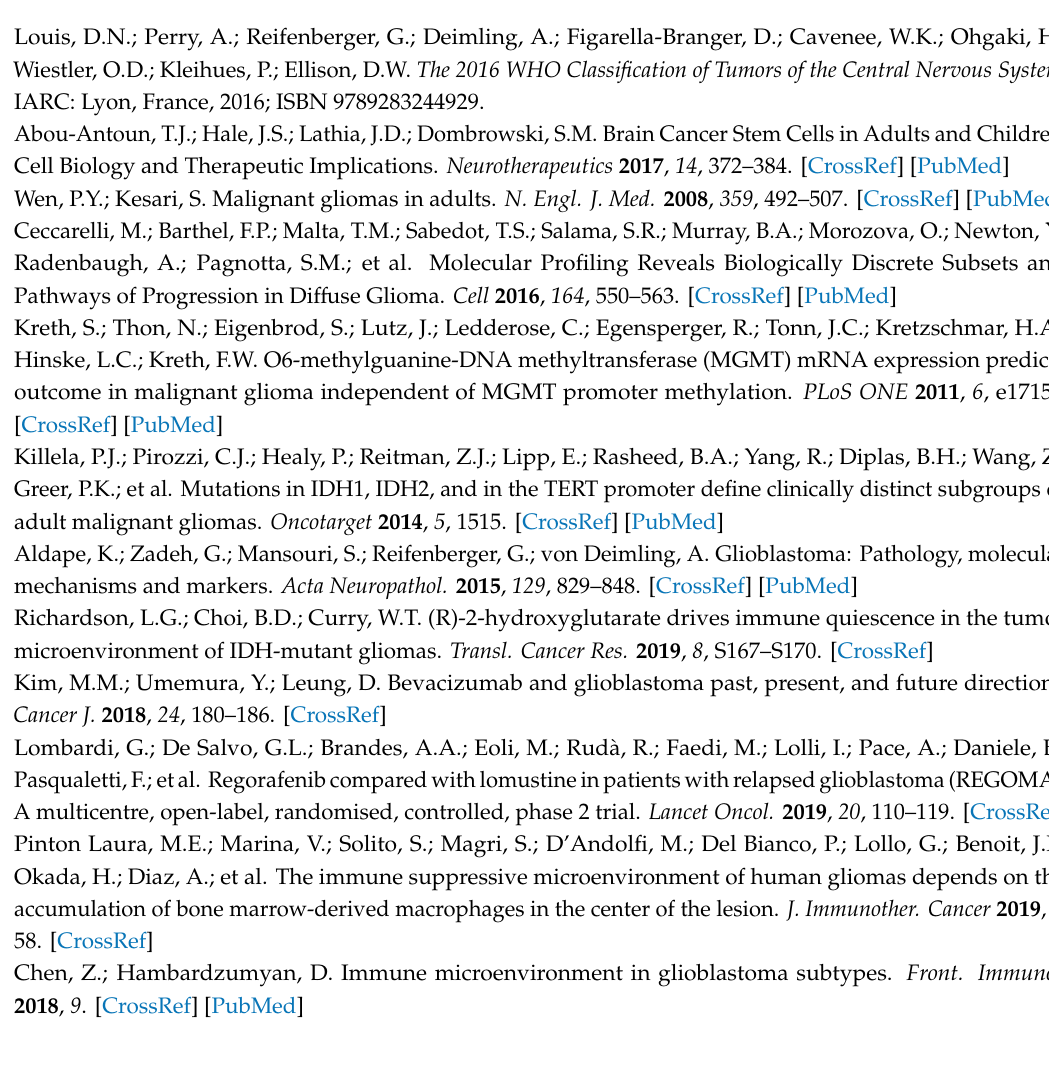
Supplementary Figure S1: Identification of periphery and tumor core area as characterized by immunohistochemical parameters. Supplementary Figure S2: Immune infiltrate distribution in non-neoplastic brain tissue. Supplementary Table S1: Antibodies employed in the study and experimental procedure for immunohistochemical